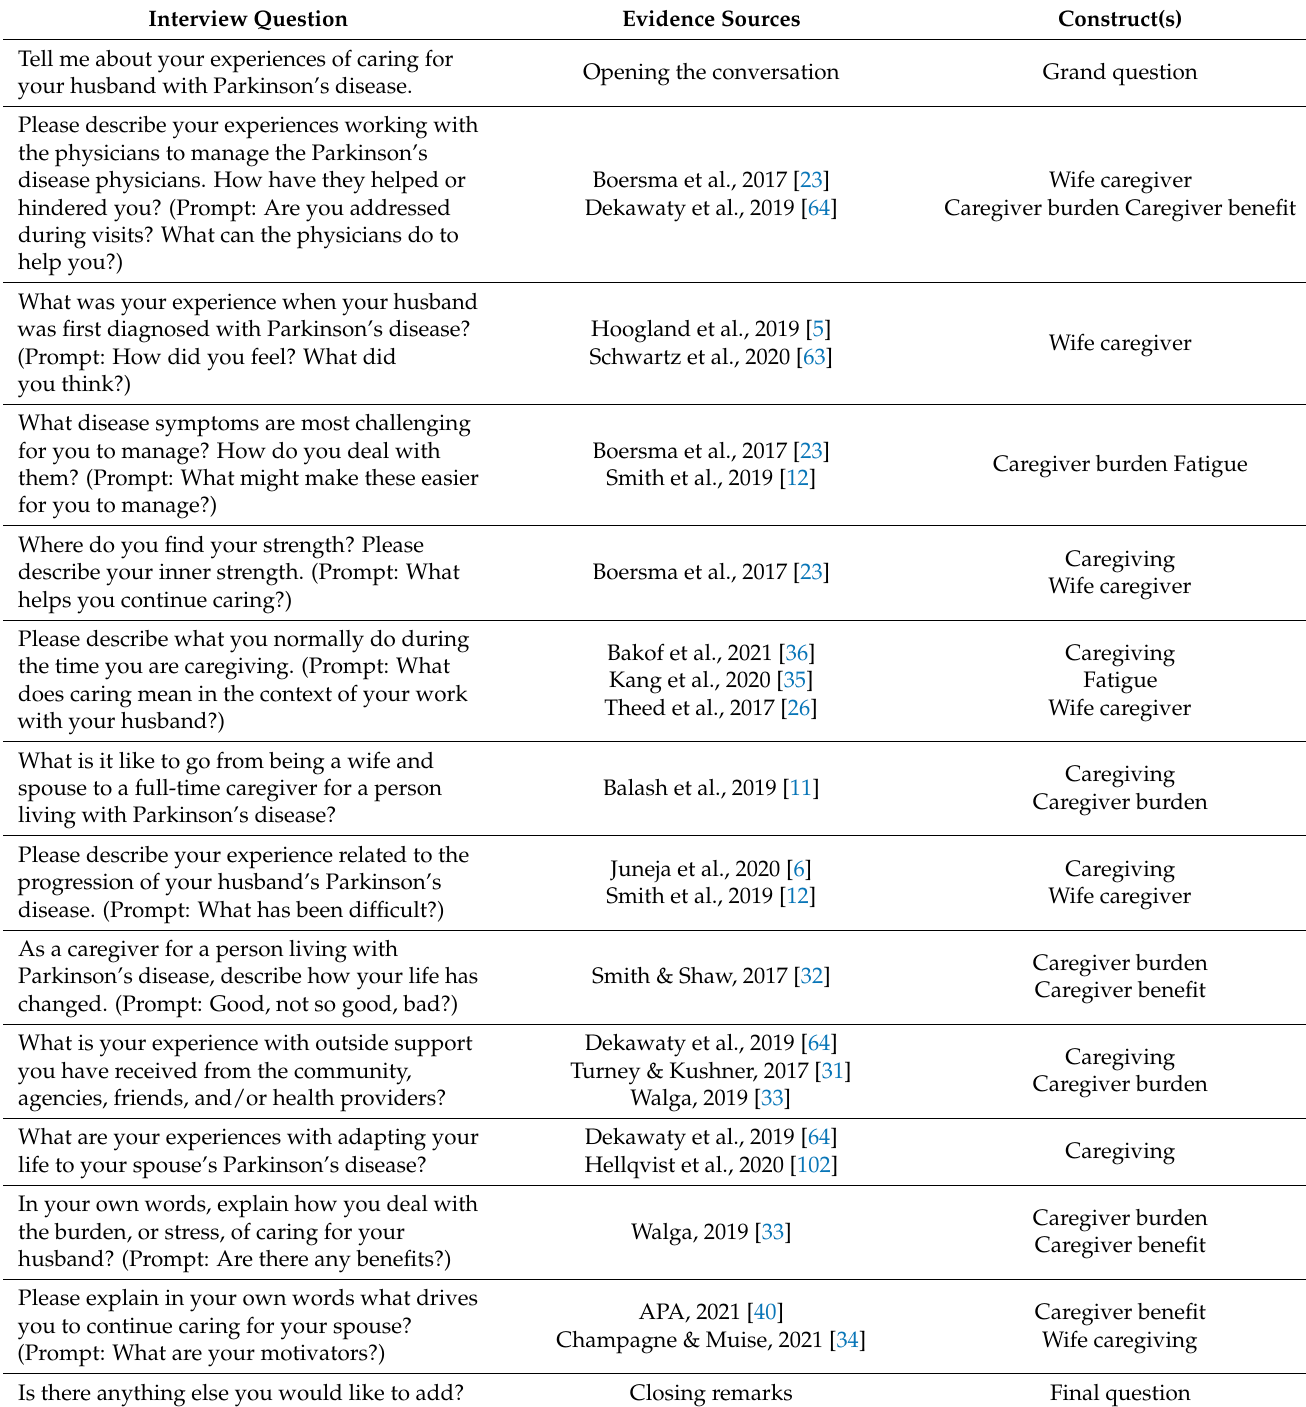
Table 2. Semi-Structured Interview Guide with Evidence